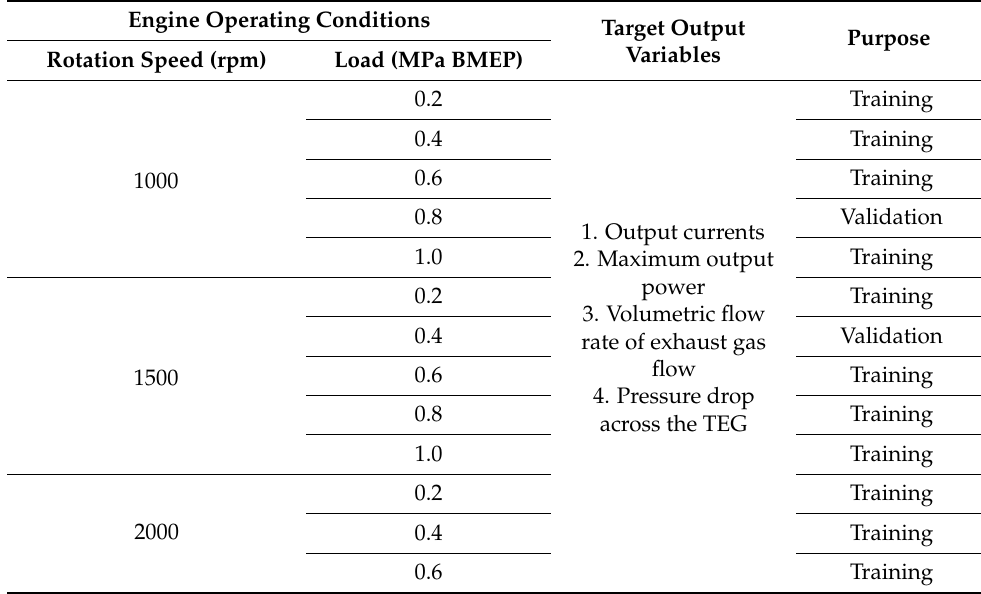
Table 1. Engine operating conditions used for ANN training and